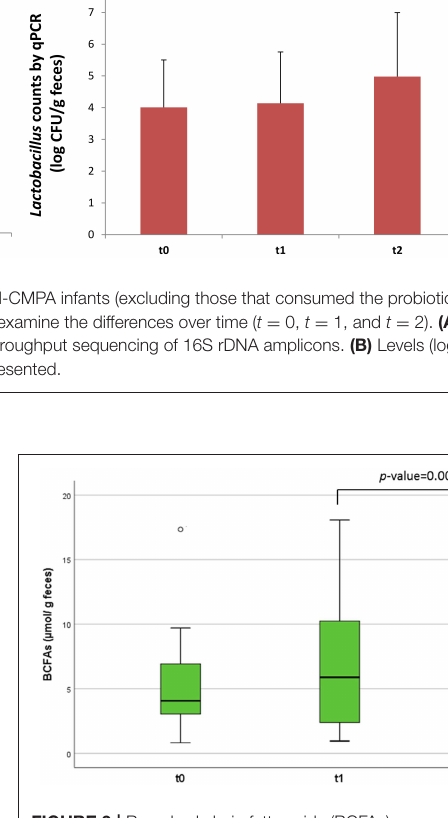
FIGURE 3 | Branched chain fatty acids (BCFAs) concentration ( µ mol/g of feces) in the patients’ fecal samples at different time points. The lines inside the rectangles indicate the medians and the whiskers the maximum and minimum values. The dots outside the rectangles are suspected outliers. Comparisons were made with the Wilcoxon signed-rank test to examine changes over time ( t = 0, t = 1, and t =